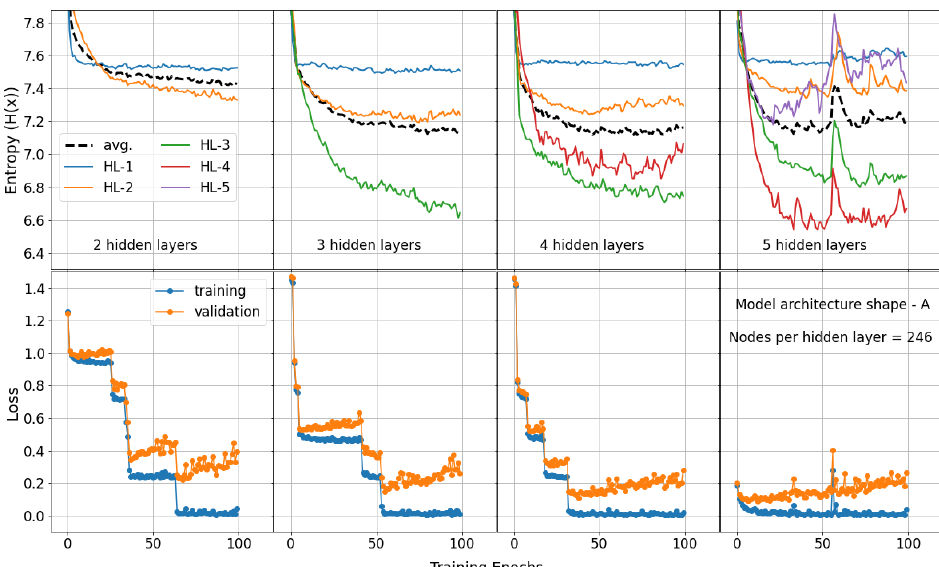
Figure 6. First row of figures show the entropy profile of four different shallow neural networks. Second row shows the corresponding training and validation losses. Number of hidden layes were changed from two to five and each hidden layer (HL) consist of 246 nodes. Note that the black curves in the first row of figures show the average (avg.) entropy of each model. These models were trained using 60,000 MNIST-digits images with 33% validation split. NLLLoss [41] was used as the loss function and the Adam optimizer [42] with learning rate 0.001 was used for the model